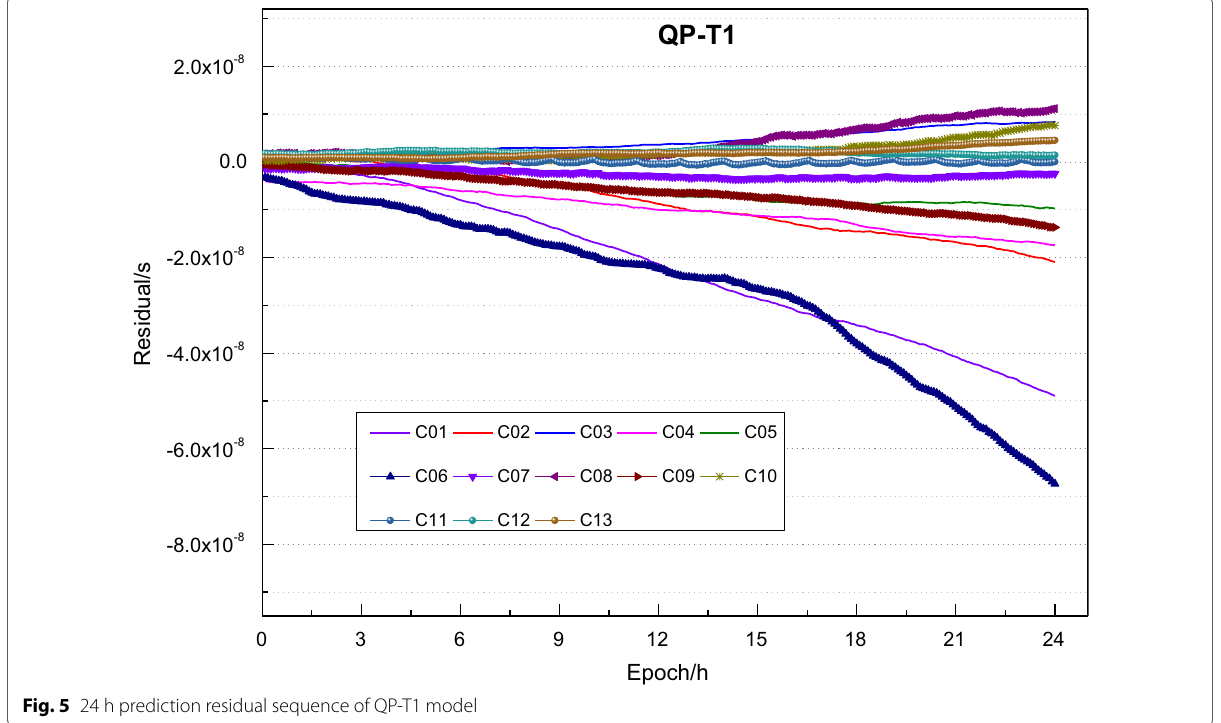
Fig. 5 24 h prediction residual sequence of QP-T1 model